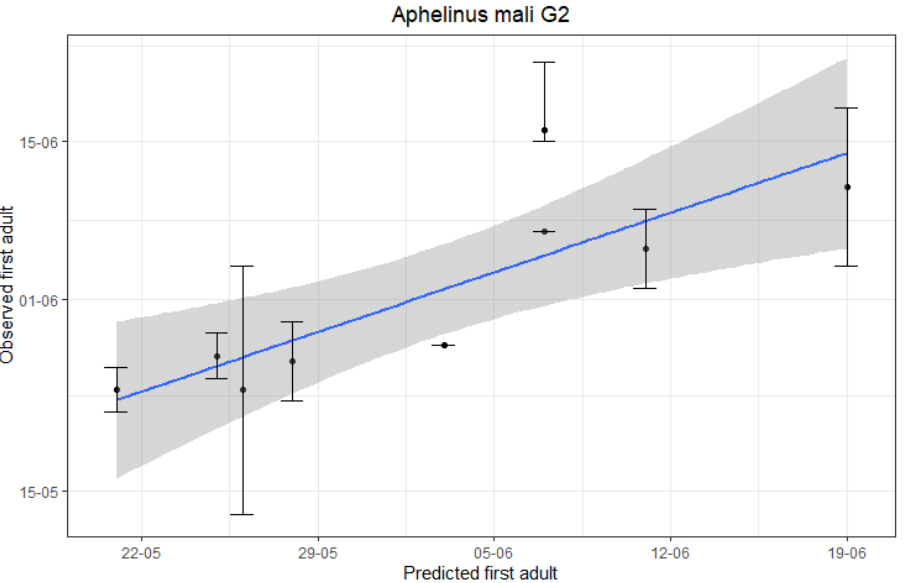
Figure 3. Linear regression analysis of predicted second-generation (G2) A. mali adults vs. observed second G2 A. mali adults by monitoring in apple orchards. Error bars represent the last date when yellow sticky monitoring plates were checked after the end of the G1 flights and for which none of the checked plates showed newly caught A. mali adults and the first date that newly emerging G2 A. mali adults were again detected on the sticky